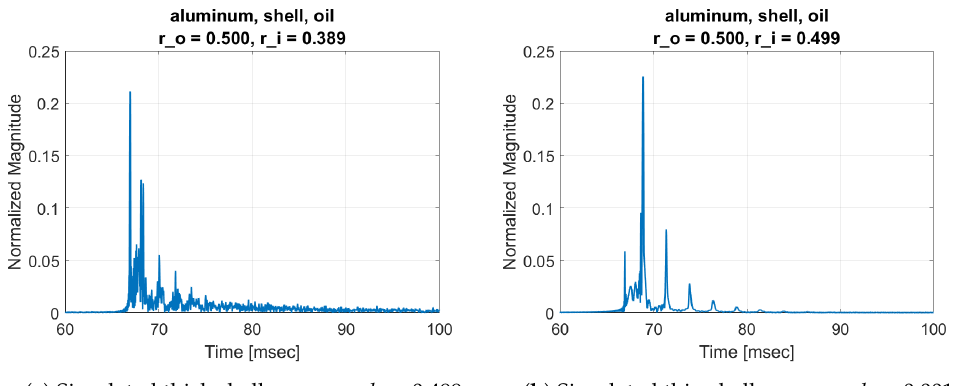
Figure 1. The normalized magnitude of simulated ( a ) thick and ( b ) thin backscattered responses for an aluminum shell filled with octane. The specular reflection is the main component seen in the ( a ) thick shell, while resonance is the main component in the ( b ) thin shell. The signals have been normalized to the unit of energy, and responses have been zoomed in to the area of interest. There was no noise added to these